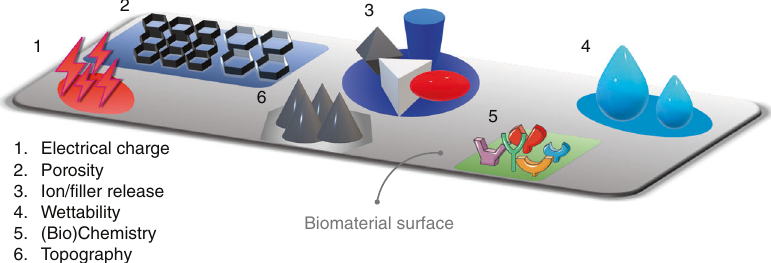
Fig. 2 Examples for different surface physicochemical modi fi cations/cues used to improve the degree of smartness on